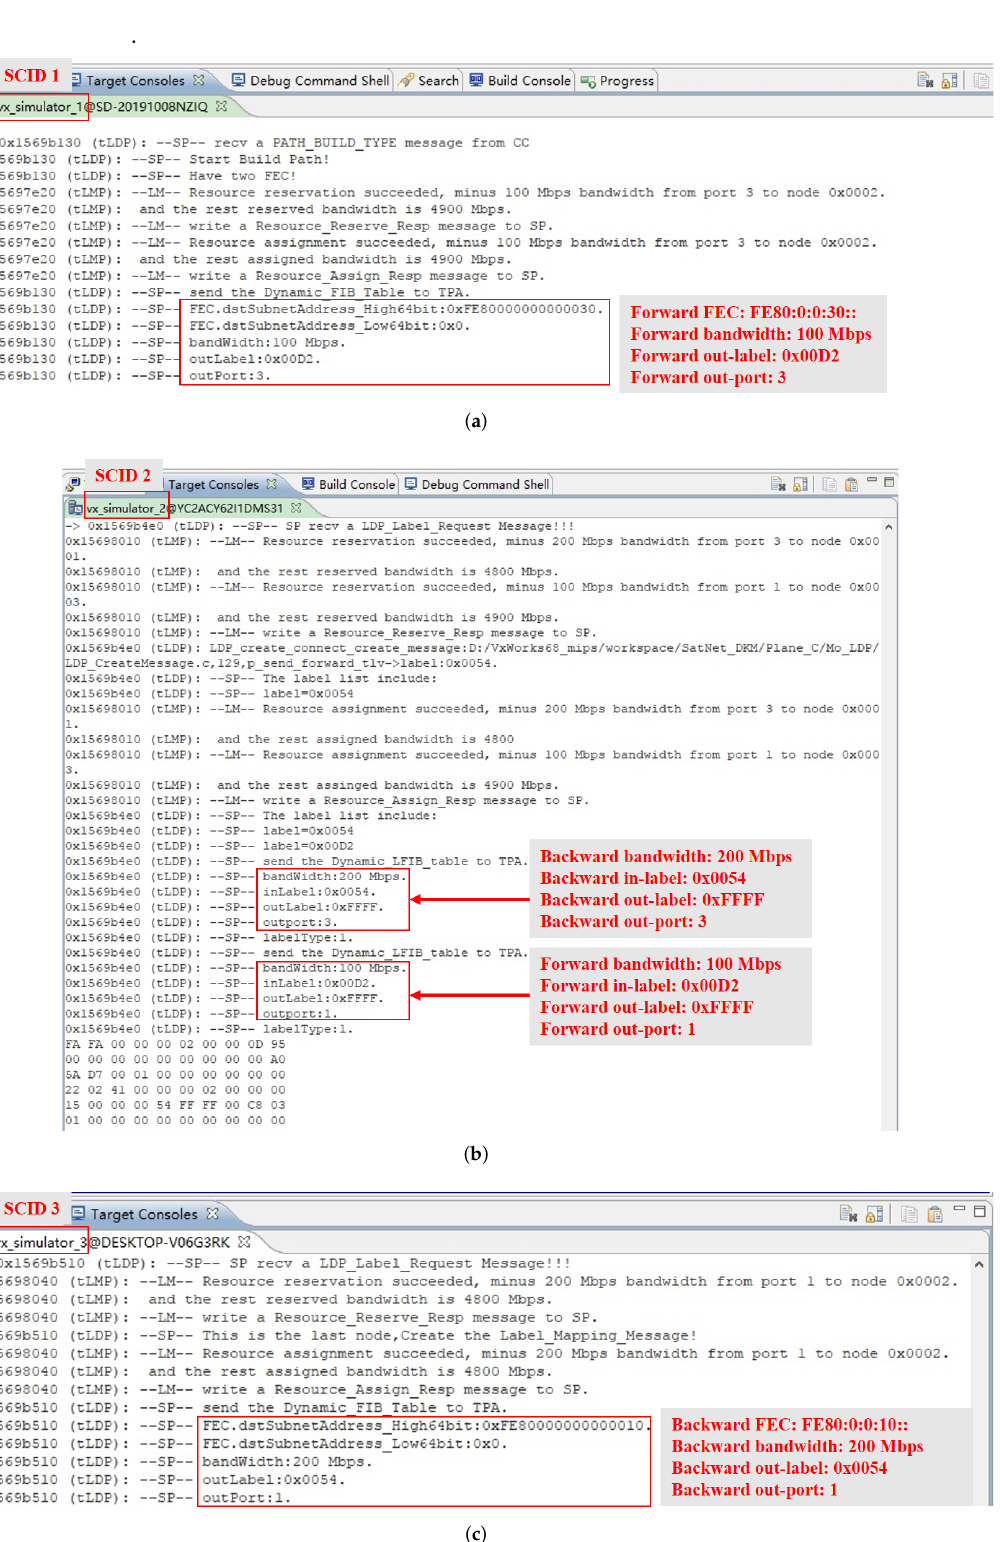
Figure 21. The label distribution process of label switching path setup under QoS requirements and the circumstances of a bi-directional link between node vx_simulator_01 (ingress LER, SCID 1), node vx_simulator_02 (LSR, SCID 2), and node vx_simulator_03 (egress LER, SCID 3) in the semi-physical platform. ( a ) The label distribution process in node vx_simulator_01 (SCID 1). ( b ) The label distribution process in node vx_simulator_02 (SCID 2). ( c ) The label distribution process in node vx_simulator_03 (SCID